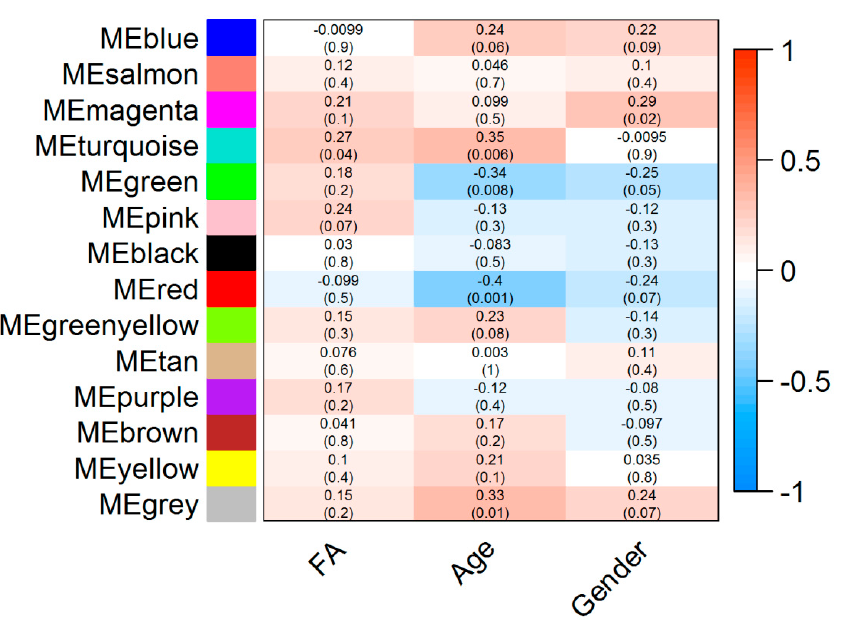
Figure 1. Module-trait associations. Each row corresponds to a module eigengene (ME) while each column corresponds to either phenotype (FA: Food allergy) or demographic traits such as age and gender. Each cell contains the corresponding correlation coefficient (display at the top of the cell) and corresponding p-values for each module (display at the bottom of the cells within parentheses). Blue and red colours of the spectrum on the right denote low and high correlation, respectively.